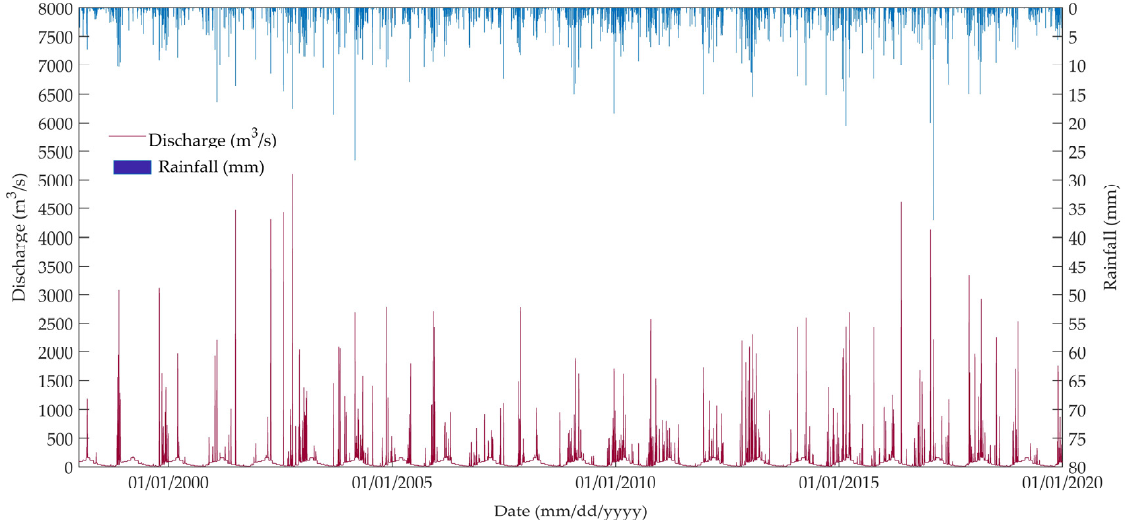
Figure 5. Continuous simulation results from 1 January 1998 to 31 December 2019.